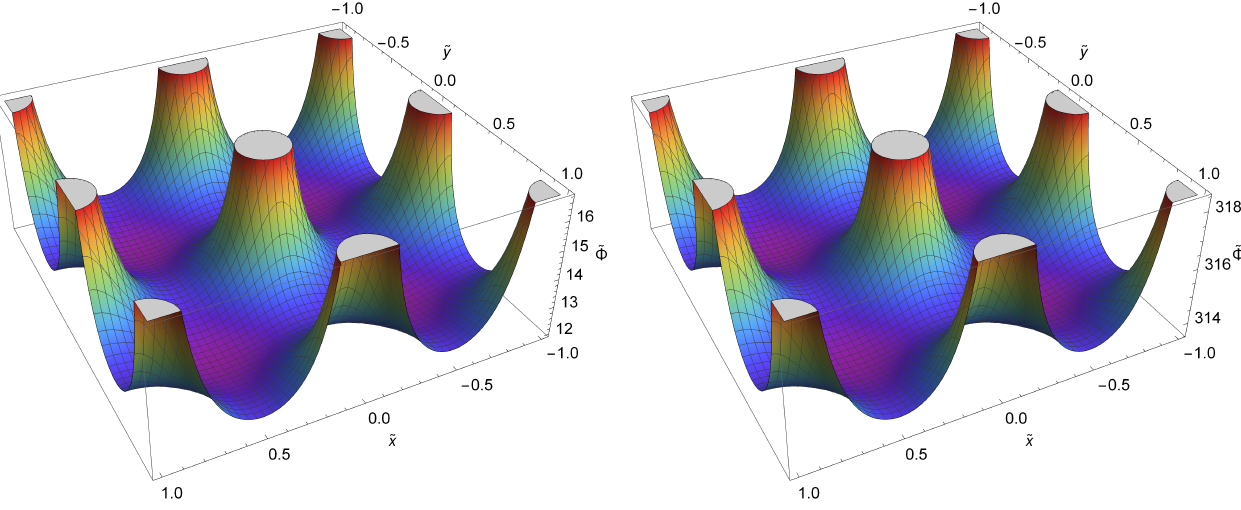
(cid:2) − (cid:3) − 1 G N m / ( c 2 al ) (cid:98) Φ for ˜ λ eff = 1 ( left panel ) and ˜ λ eff = 5 ( right